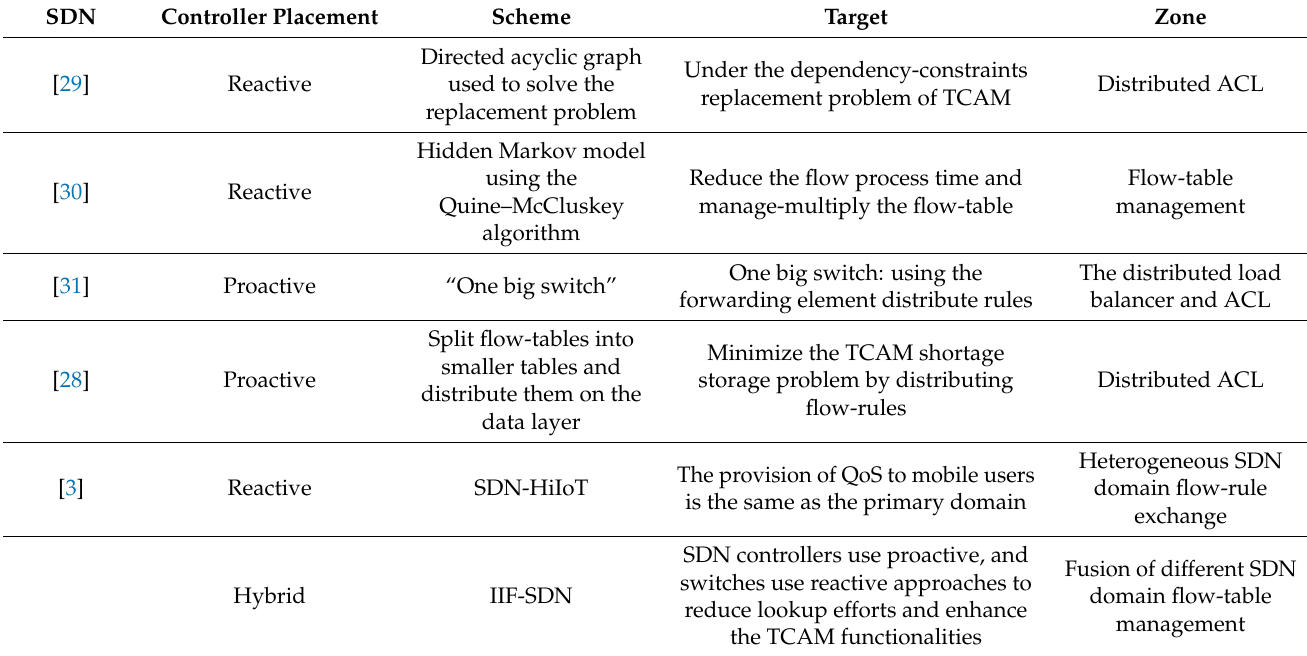
Table 1. Comparison of the improvement of TCAM, flow-table, and flow-entry utilization.